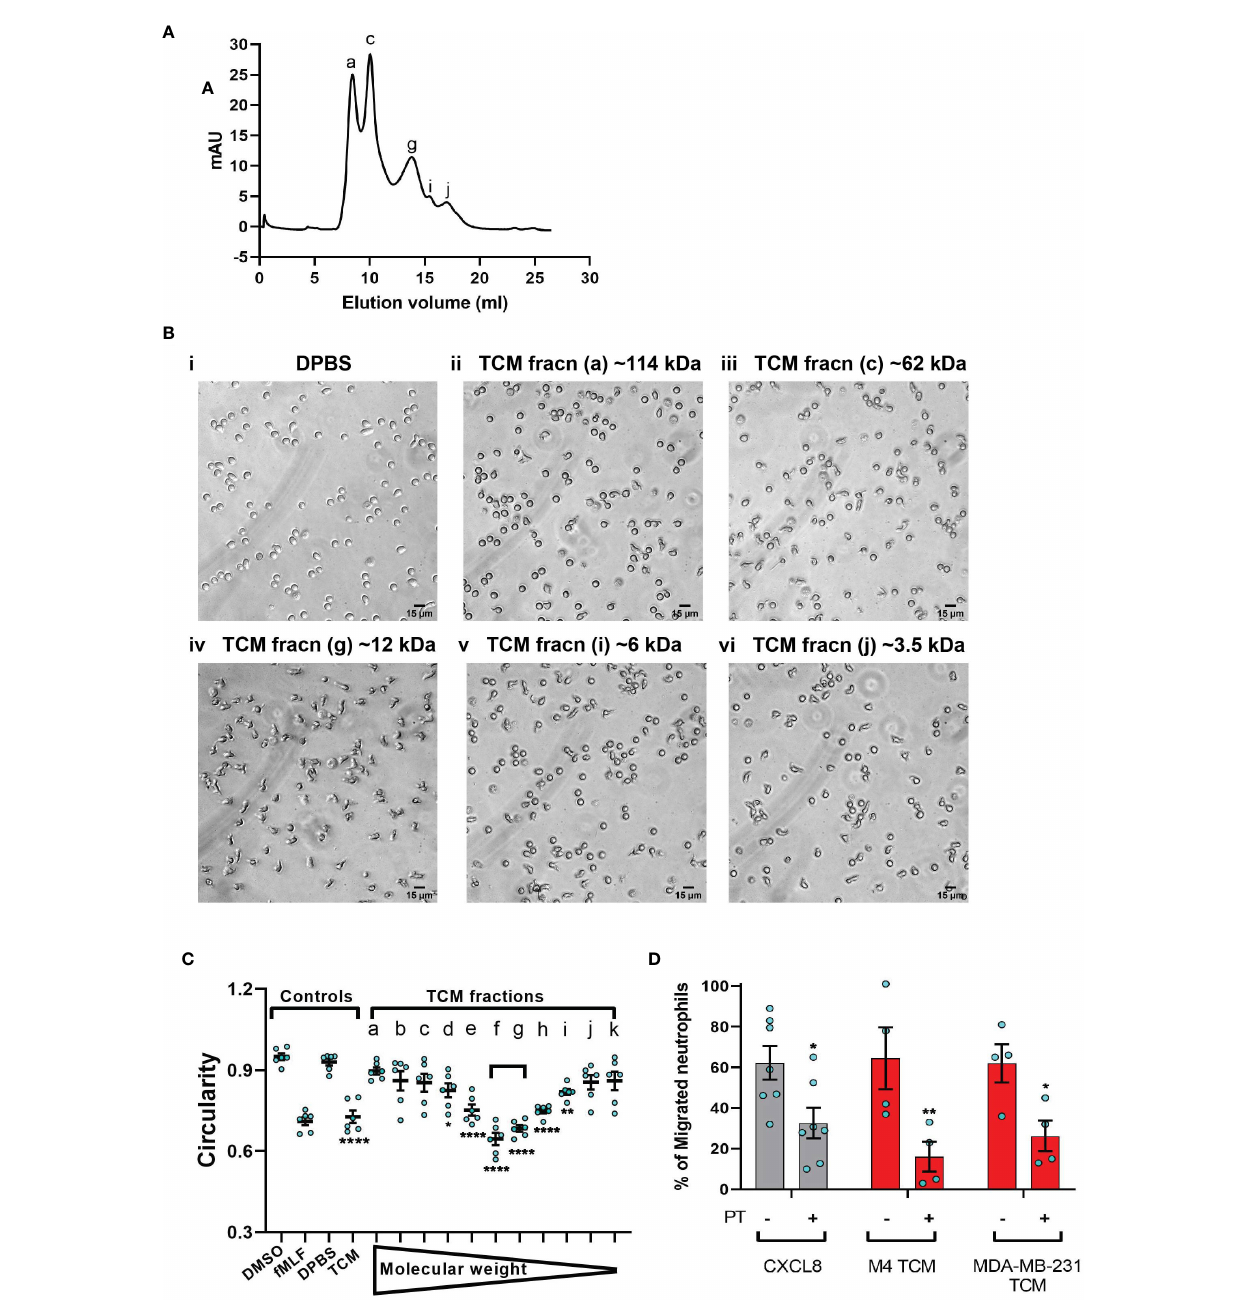
FIGURE 7 | MDA-MB-231-derived active factors are ~12 kDa. (A) Representative size exclusion chromatography elution pro fi le of TCM from MDA-MB-231 cells. (B) Representative bright fi eld images of neutrophils exposed to vehicle control DPBS (Bi) or TCM peak fractions (fracn) (Bii-vi) as labeled in (A) and corresponding to different molecular weights. (C) Graph depicting the circularity of neutrophils stimulated with controls (DMSO, fMLF, DPBS, TCM) or equal volume of TCM fractions with gradually decreasing molecular weight. Data show mean ± SEM from N=3 individual donors with two dots for each donor representing mean circularity of all neutrophils in two randomly selected imaging fi elds. ****P < 0.0001, **P ≤ 0.01, *P ≤ 0.05 when compared with DPBS (one-way ANOVA with Dunnett ’ s multiple comparisons test). (D) Graph depicting the percentage of neutrophils that migrated into the bottom chamber of the transwells containing equal volume of TCM or 20 nM CXCL8 in the presence or absence of PT. Bars show mean ± SEM from N=4-7 individual donors represented by each dot. **P ≤ 0.01, *P ≤ 0.05 when compared with corresponding PT- values (two-way ANOVA with Sidak multiple comparisons